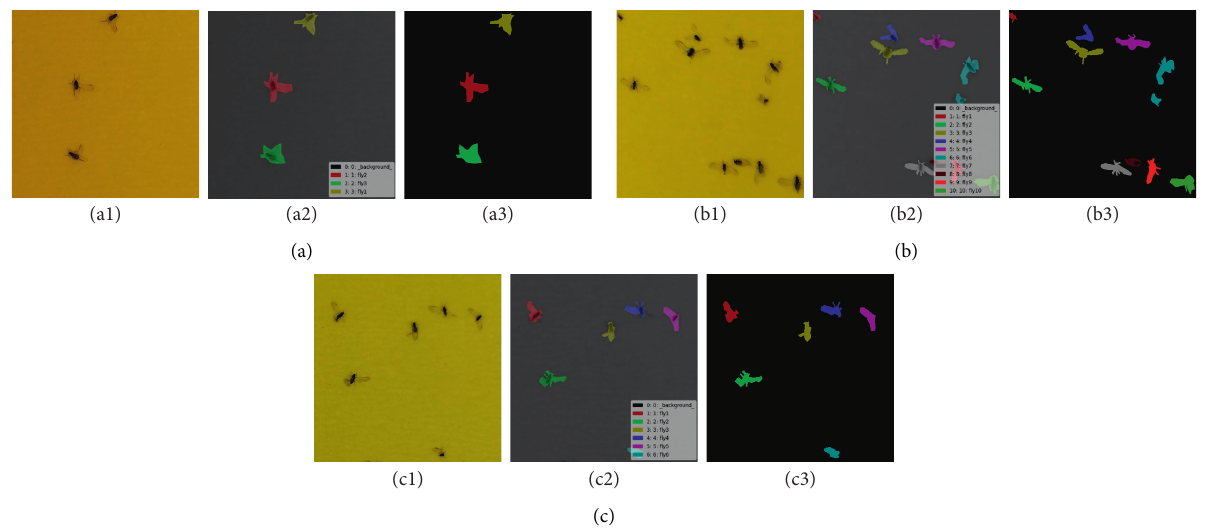
Figure 2: Raw data and label